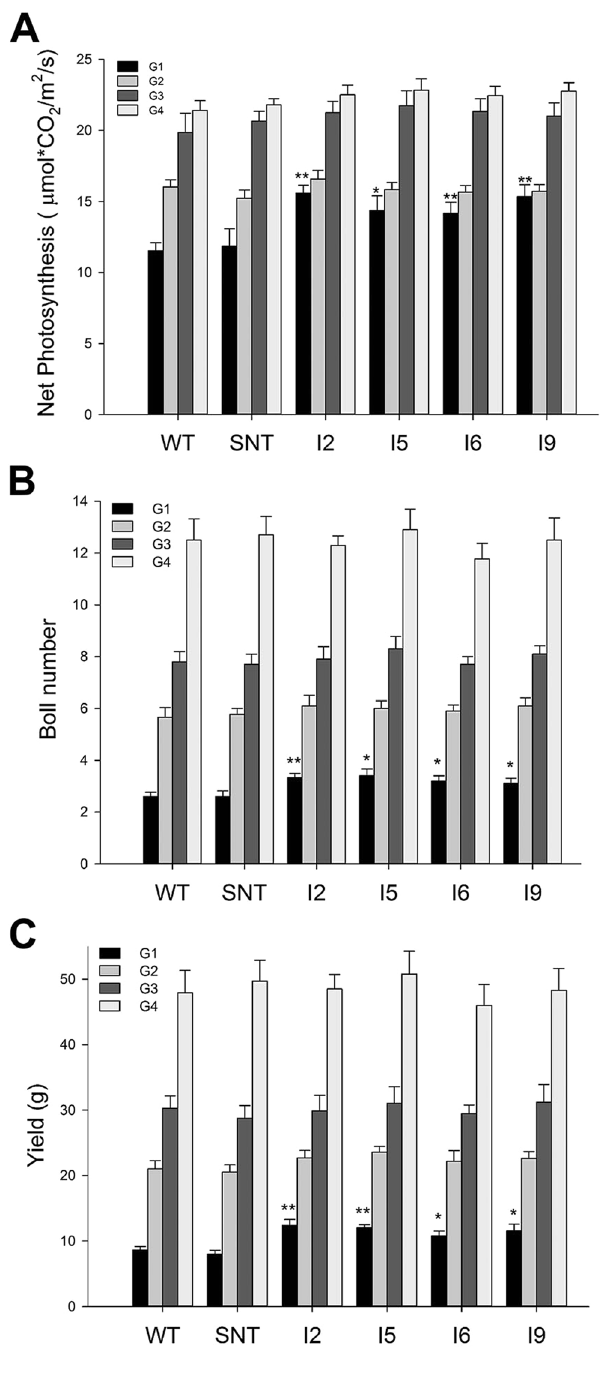
Figure 7. Photosynthetic rate, boll number, and cotton seed yield of cotton lines under differential irrigation conditions in greenhouse. WT, wild-type cotton (Coker 312); SNT, segregated non-transgenic cotton; IPT2 to IPT9, four independent IPT -transgenic cotton